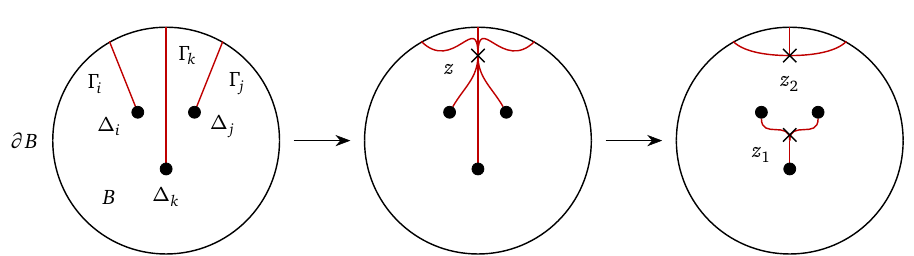
Figure 4: Picture of topological manipulations permitted on (three) thimbles in h whenever these are linearly dependent. We show the projections of the deformation to the base. The initial configuration (left) are three non-compact thimbles attaching to three disconnected discriminant components. The final configuration (right) lifts to a compact 2-cycle and a non-compact 2-cycle which can be further deformed into ∂ B